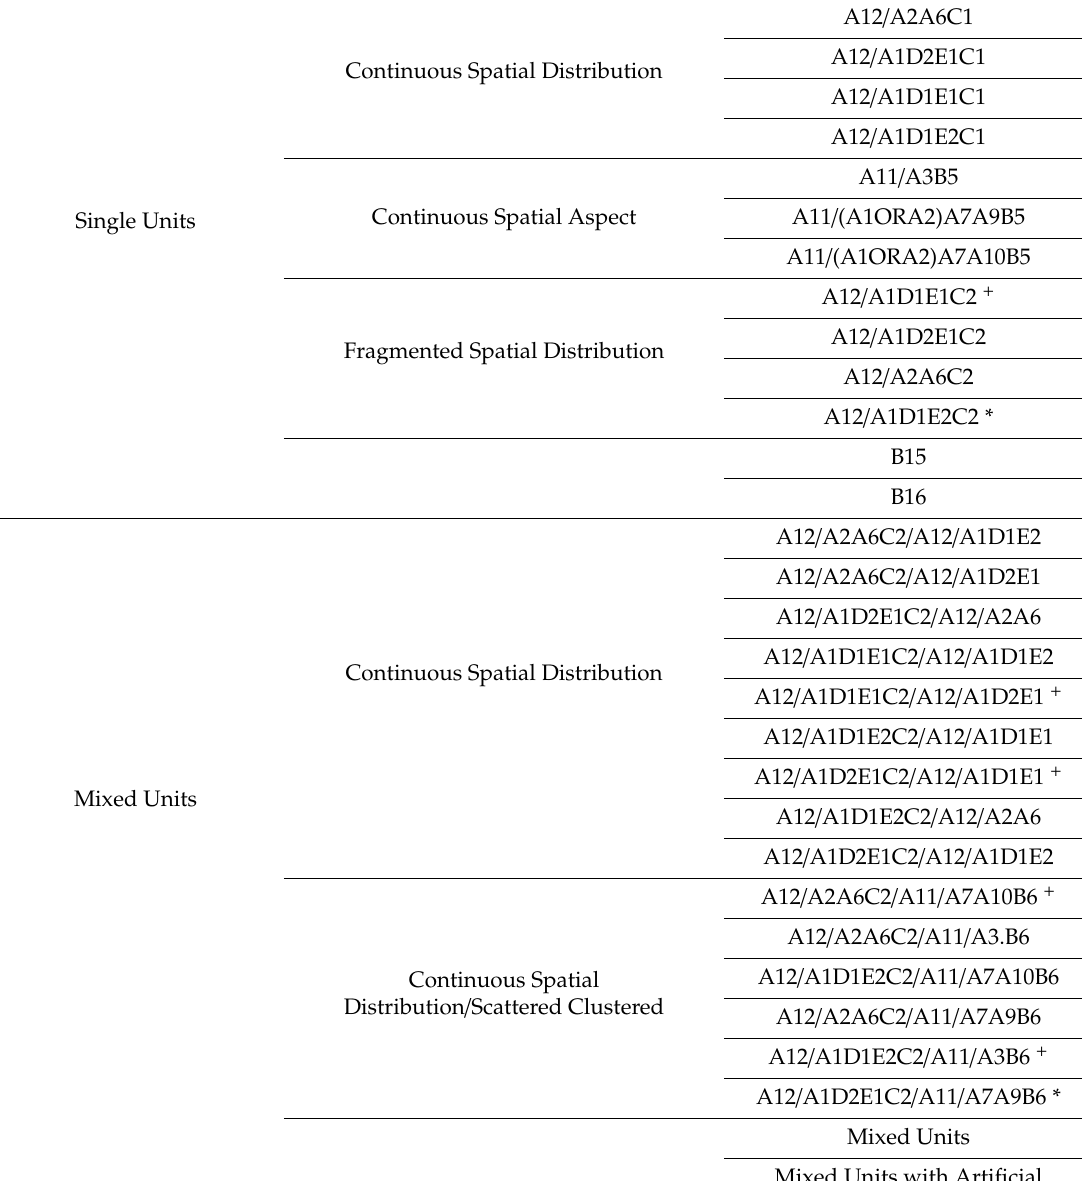
Table 9. List of the LO classes found by automatic classifiers and visual